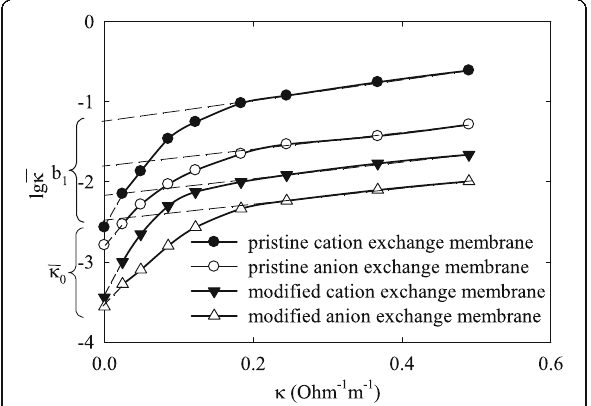
Fig. 5 Logarithm of membrane conductivity vs conductivity of outer aqueous NaCl solution Fig. 6 Ratio of C